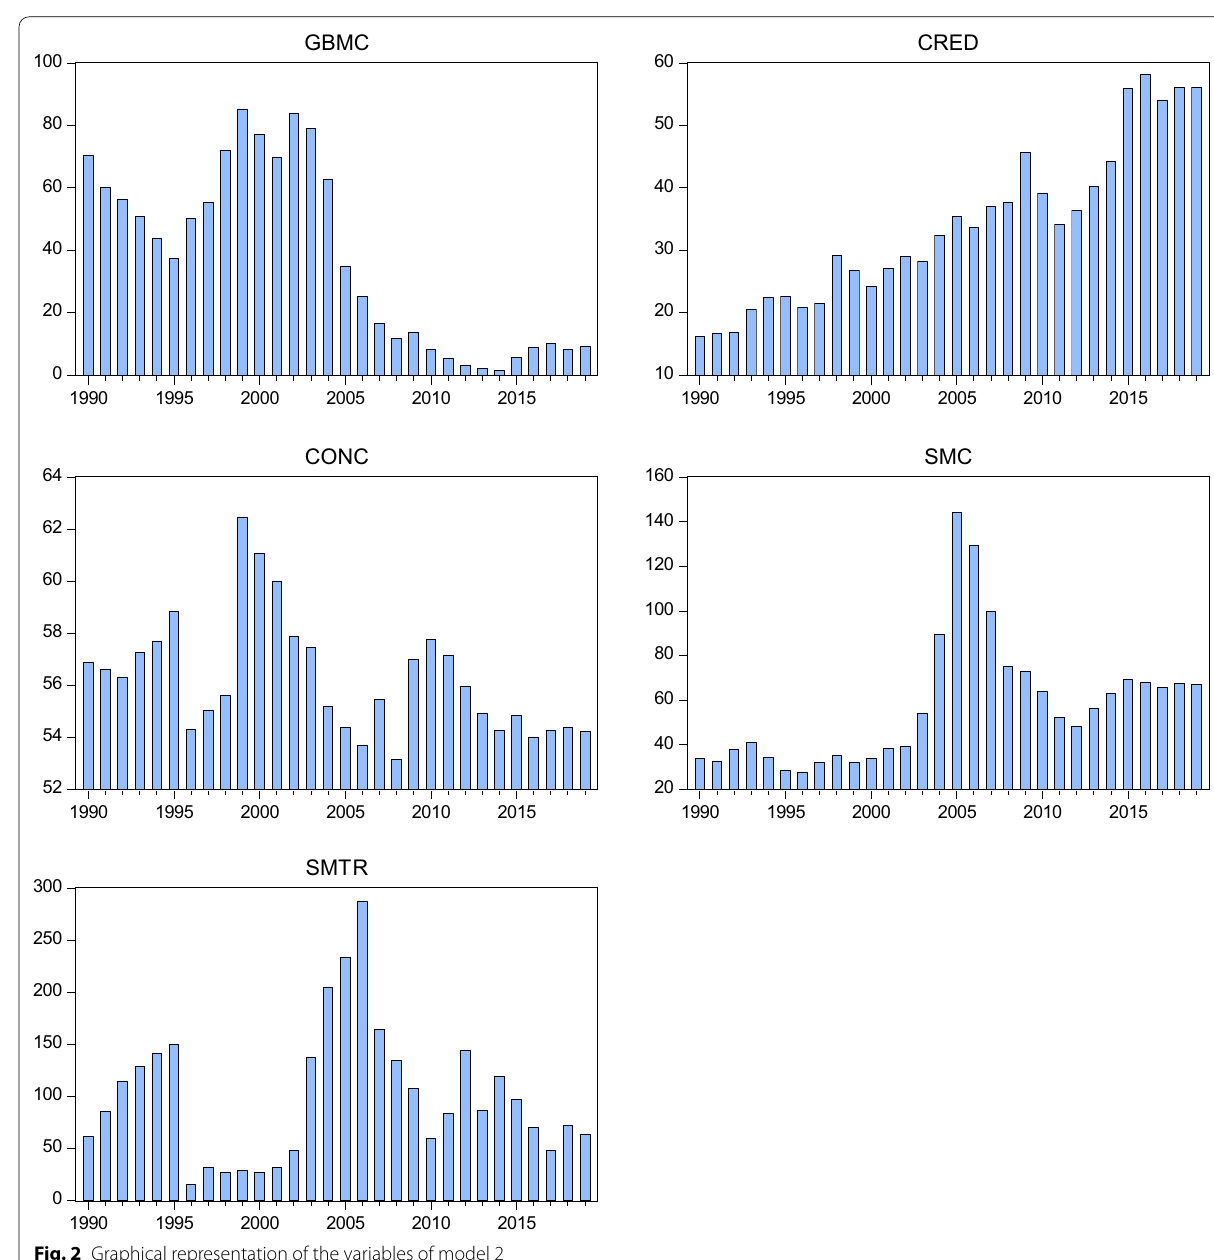
Fig. 2 Graphical representation of the variables of model